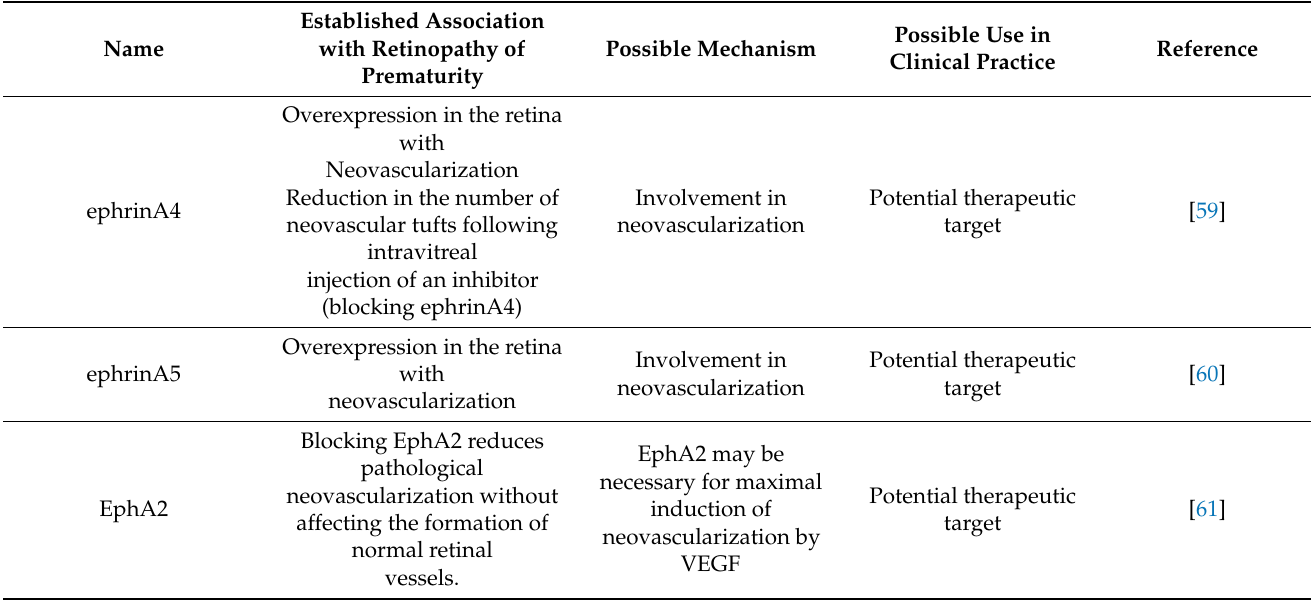
Table 2. A summary of the identified associations of Eph and ephrins with retinopathy of prematurity.